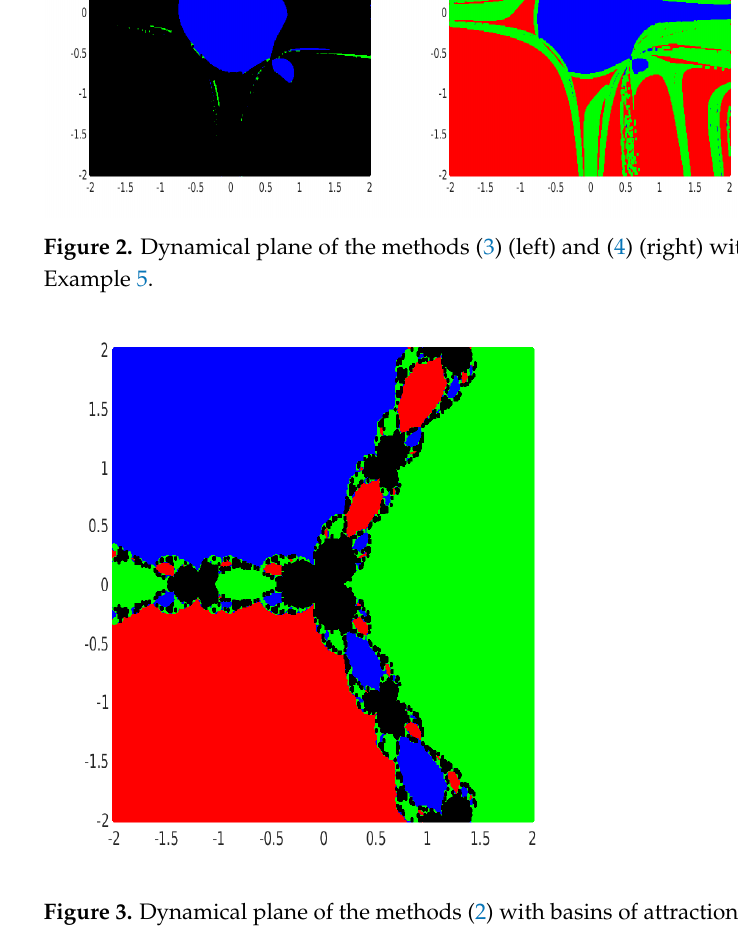
Figure 3. Dynamical plane of the methods (2) with basins of attraction for Example 6.